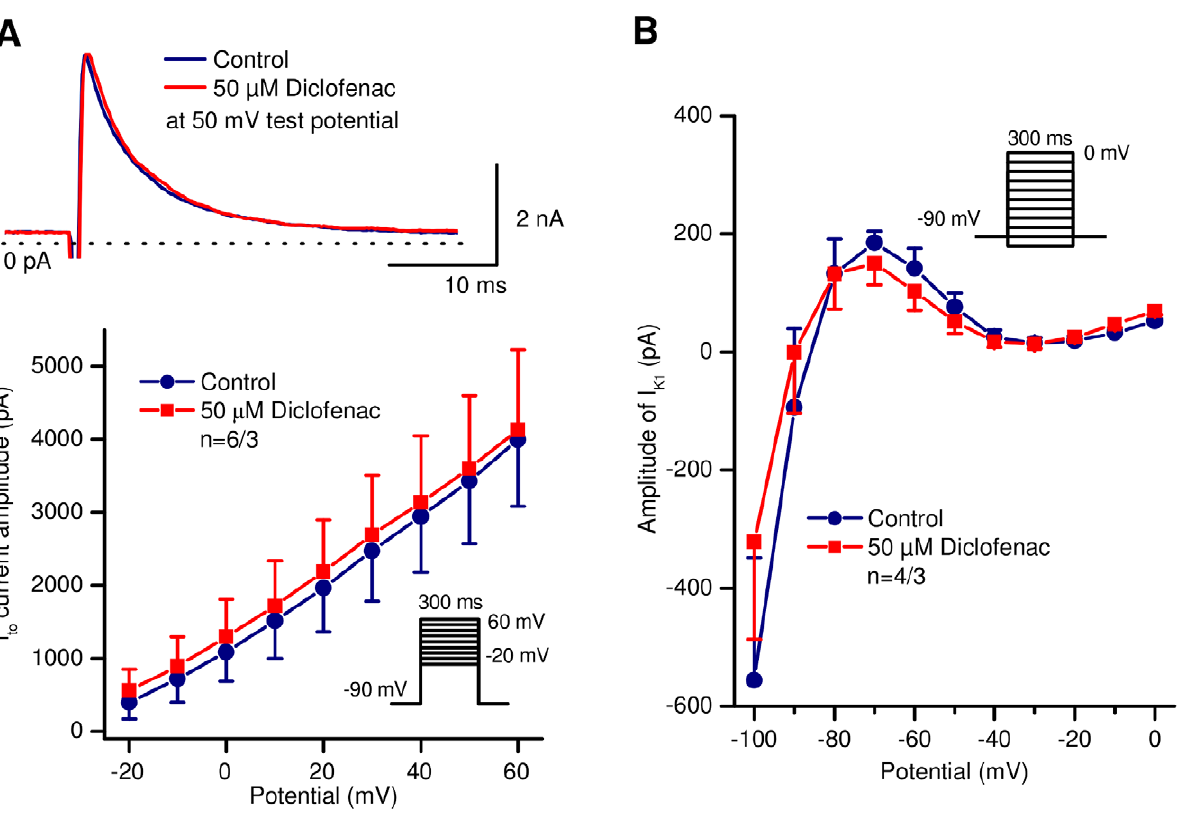
Figure 4. Lack of effect of diclofenac on the transient outward potassium (I to ) and on the inward rectifier potassium (I K1 ) currents in canine ventricular myocytes. A, top : Representative I to current traces under control conditions and after application of 50 m M diclofenac. A, bottom : Current – voltage relationships of I to under control conditions and in the presence of 50 m M diclofenac. Panel B shows steady-state current – voltage relationships of I K1 before and after application of 50 m M diclofenac. Insets depict the voltage protocol applied during measurements. Data are expressed as mean 6 SEM, n=number of measurements/number of animals.